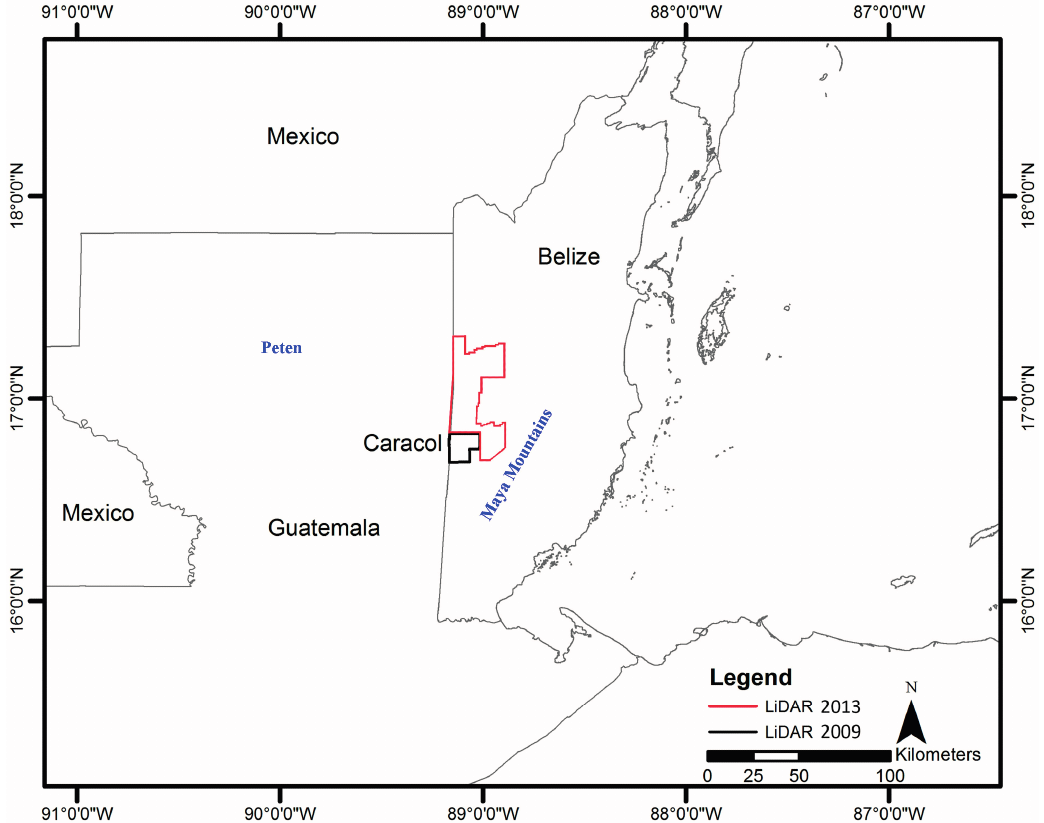
Figure 1. Map showing the areas in Belize that have been surveyed with LiDAR as a result of the 2009 and 2013